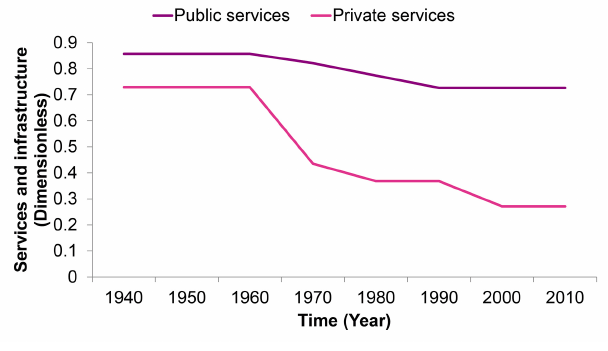
Fig. 8 . Qualitative representation of the historical trend of public and private services. The violet line marks public services, including education, medical and religious services, post office, telegraphs, public telephone, electricity and water, transport, administration, and security. The pink line indicates private services, including local shops, professional skills, local institutions, community works, and local festivities. Source: in- depth